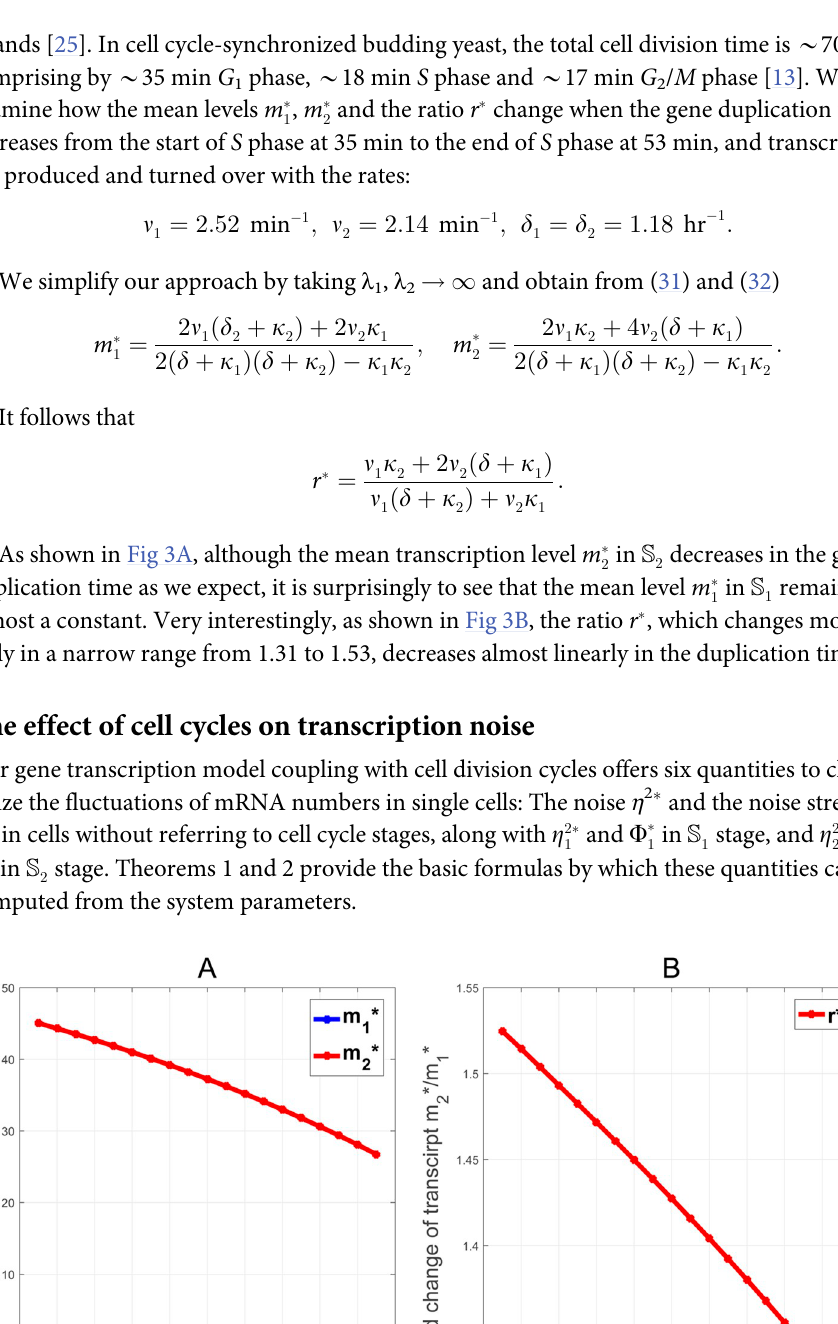
Fig 3. The dependance of the mean mRNA copy numbers m � duplication during S phase. (A) The mean level m � gene duplication time increases from 35 min to 53 min in S phase. (B) The ratio r � decreases almost linearly from 1.53 to 1.31 as the gene duplication time